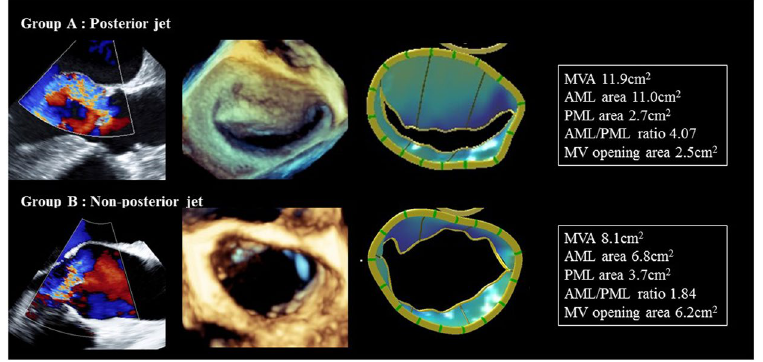
Figure 4. Representative examples of Group A (posterior jet) and Group B (non-posterior jet). MVA, mitral valve annulus; AML, anterior mitral leaflet; PML, posterior mitral leaflet; MV, mitral